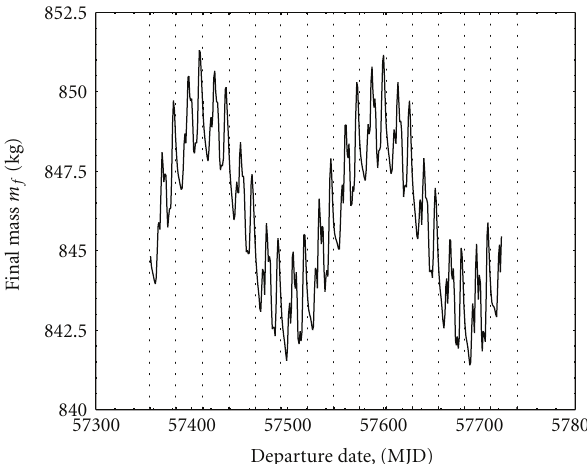
Figure 7: Final mass for 4.5-revolution 8 N transfers.